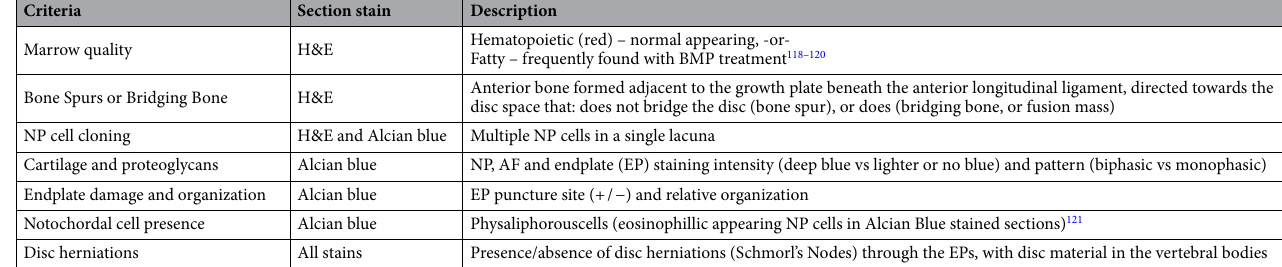
Table 2. Histology Assessment